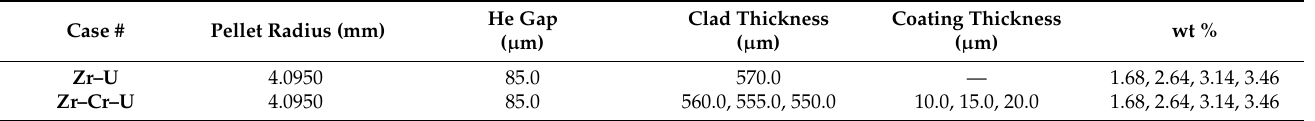
Table 4. Pin cell geometries.